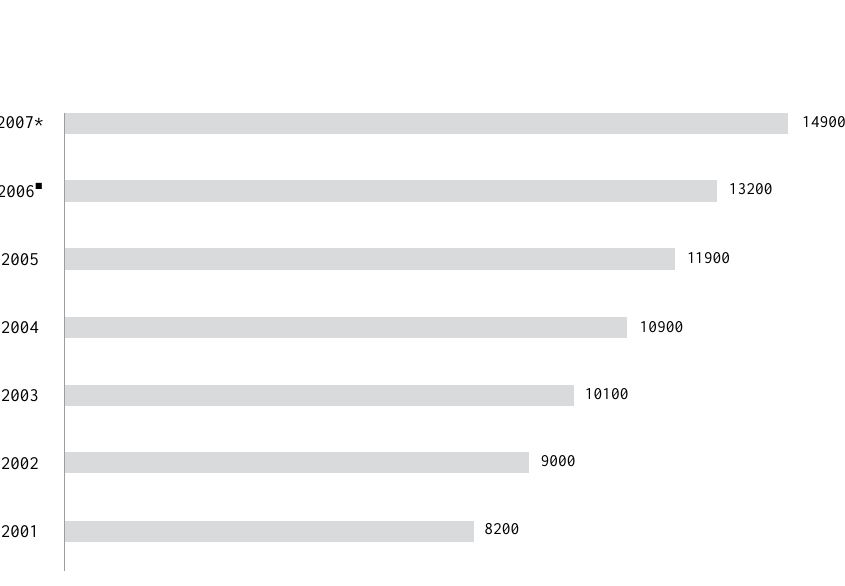
fig. 1. GDP and annual change of GDP. Source: The Department of Statistics [Lithuania in Europe 2008]